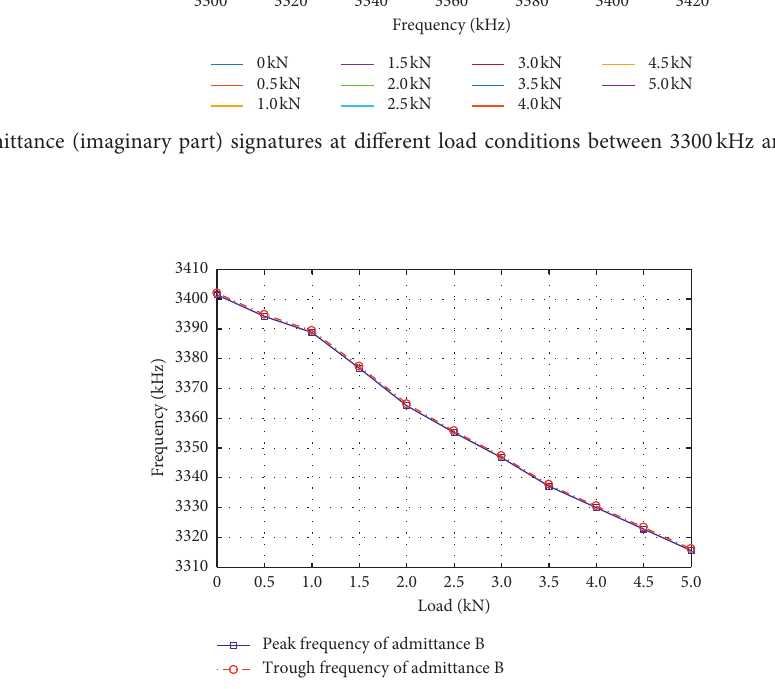
Figure 9: Frequencies corresponding to the peak and trough of the admittance signature between 3300kHz and 3420kHz excitation.